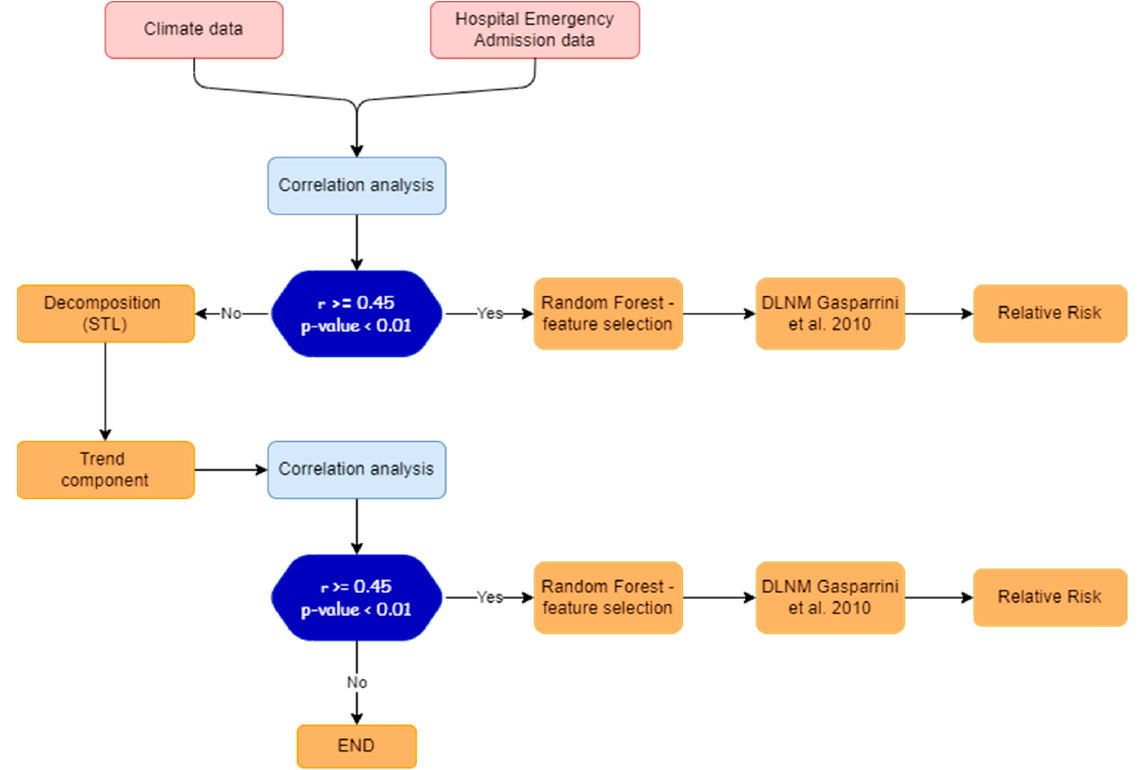
Figure 5. Experimental design of methodological procedure.